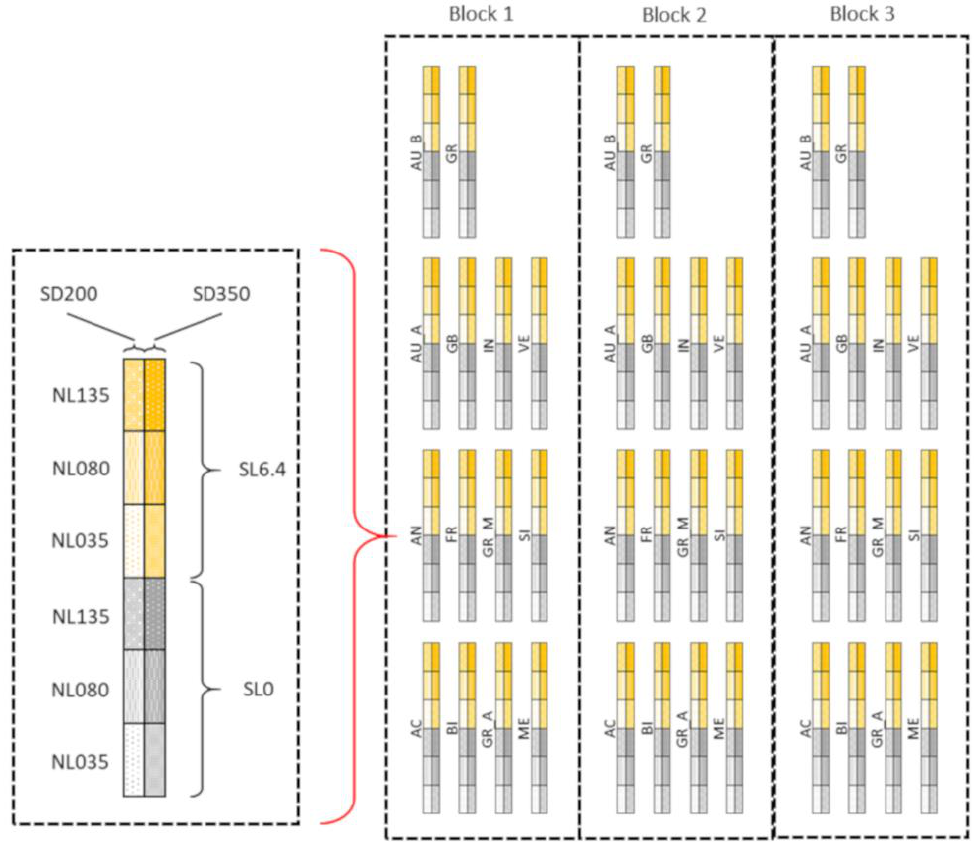
Figure 1. Experimental design and plot layout of trials (not in scale); On the left, the plot layout for each variety: SD200 and SD350 represent seeding density of 200 and 350 kg seed m − 2 , respectively; NL35, NL80 and NL135 represent the three nitrogen fertilization rates of 35, 80 and 135 kg N ha − 1 , respectively; SL0 and SL6.4 represent the two sulfur fertilization rates of 0 and 6.4 kg S ha − 1 , respectively. On the right is the disposition of plots within the blocks for different varieties.